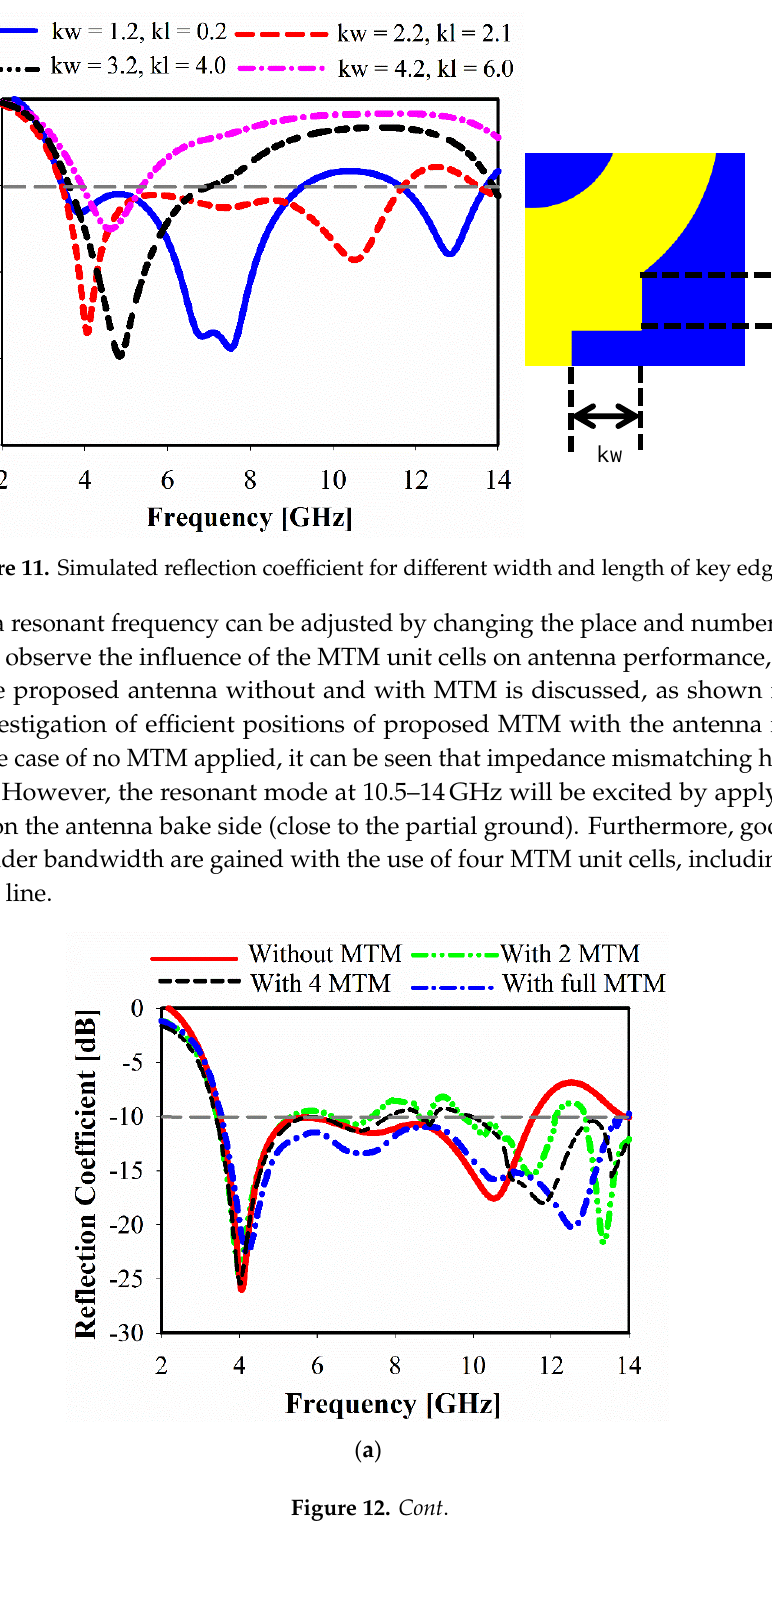
Figure 11. Simulated reflection coefficient for different width and length of key edge.